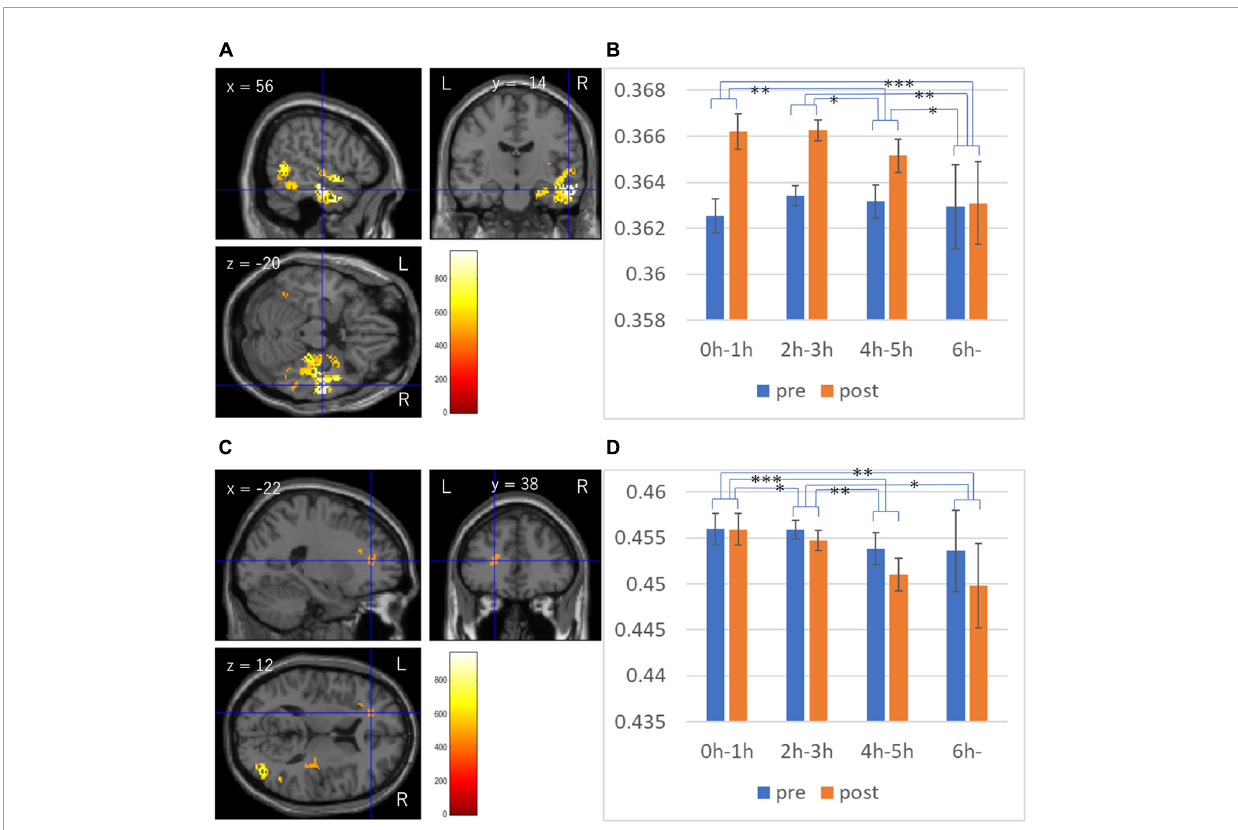
FIGURE3 Associations between TV viewing length and longitudinal changes in intracellular volume fraction (ICVF). (A,B) Results are overlaid on a “single subject” T1 image from SPM. Results were obtained using a threshold of threshold-free cluster enhancement (TFCE) of p < 0.05 based on 5,000 permutations. The color represents the strength of the t -value. The color bar represents the TFCE score. It reflects both voxel’s height and the sum of the spatially contiguous voxels supporting it; therefore, it reflects both the strength and extent of effects. Profiles of imaging values at pre and post scans (which correspond to the third and the fourth assessment visits) in the significant cluster of the extensive cluster around the right temporal gyrus (C) , and the cluster in the white matter area of the left inferior frontal gyrus (D) . ∗ p < 0.05, ∗∗ p < 0.01, ∗∗∗ p < 0.001, in the t -tests comparing the raw pre to post differences of ICVF in the significant clusters between